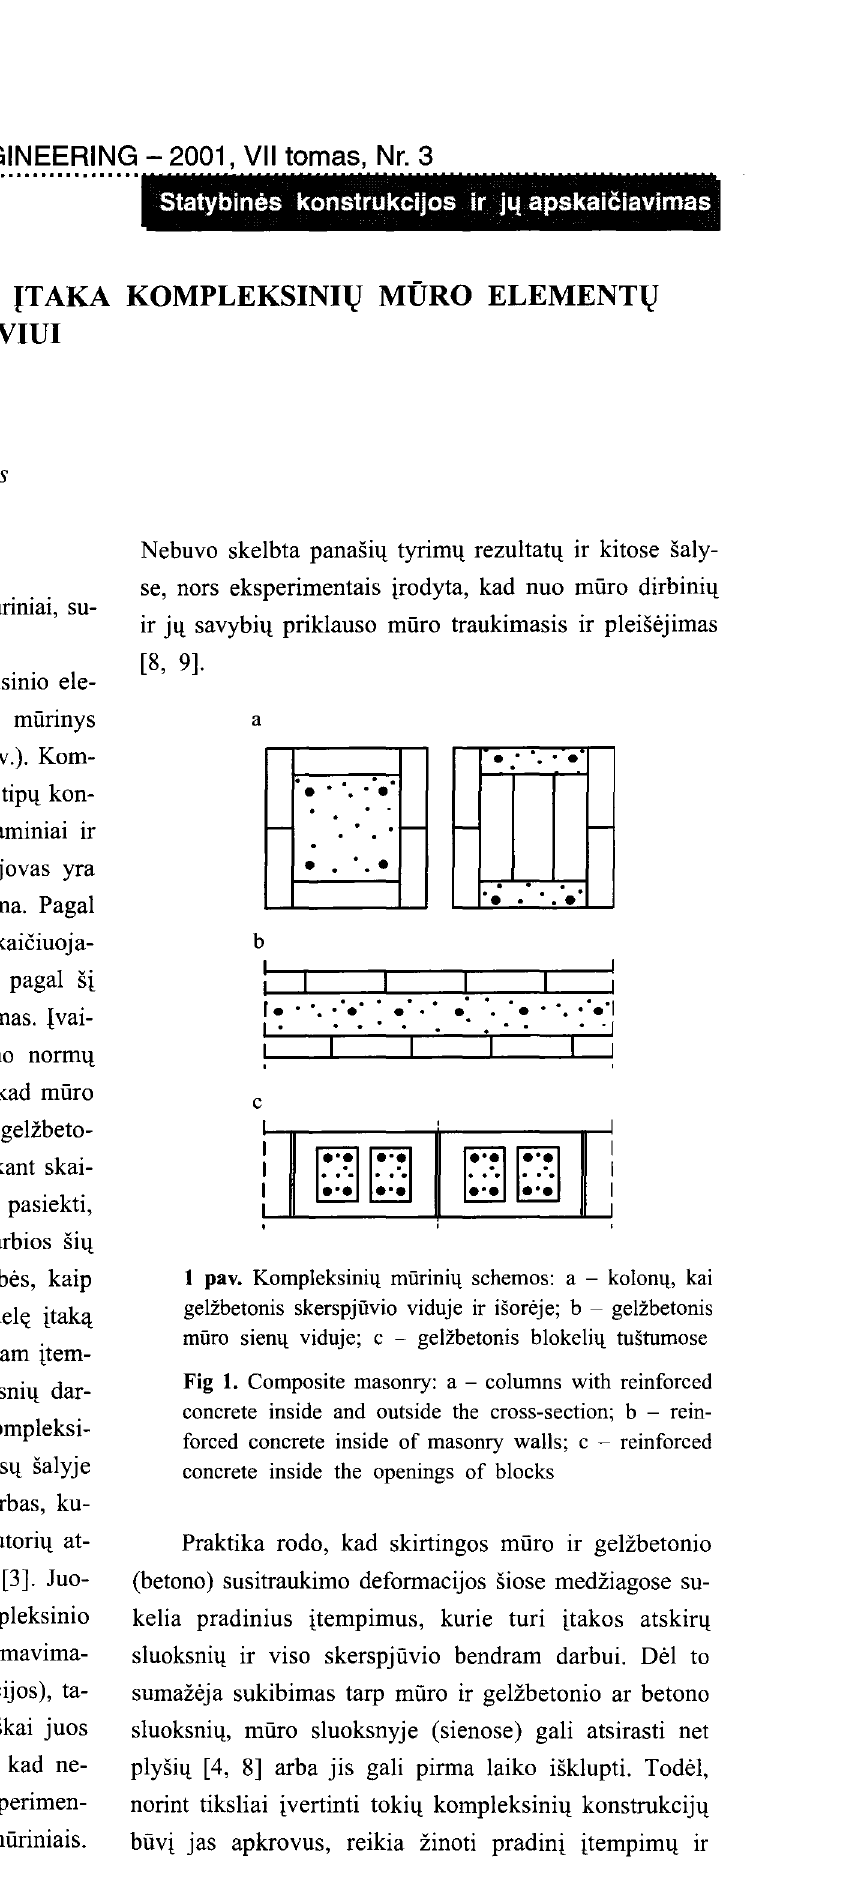
plysill [ 4, 8] arba jis gali pirma laiko isklupti. Todel, biivi jas apkrovus, reikia zinoti pradini itempimll